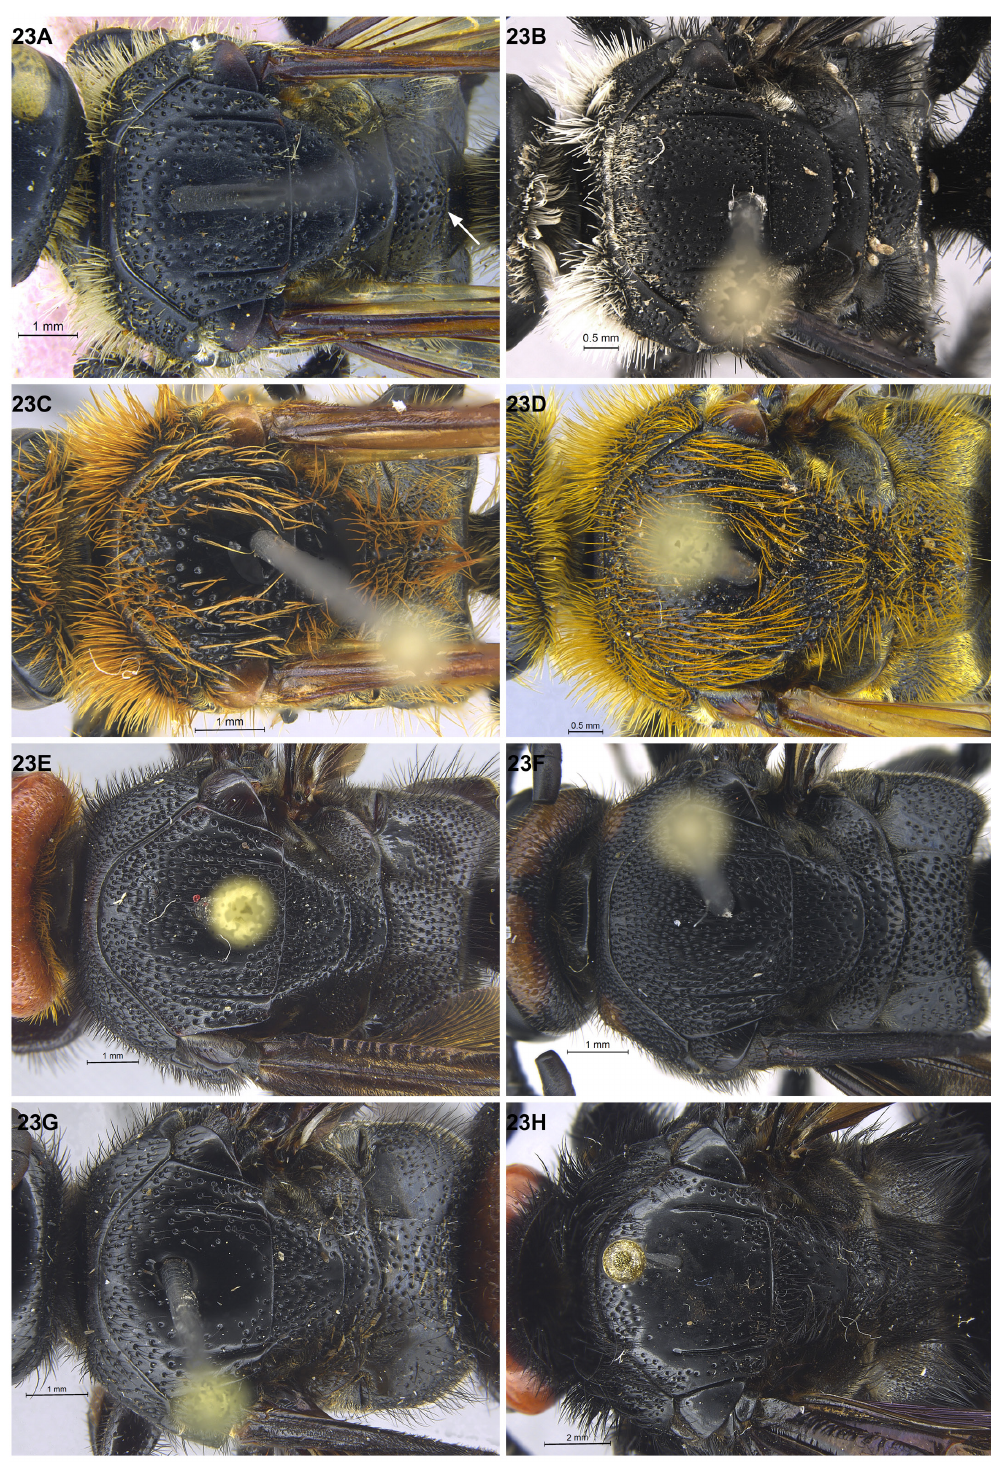
Fig. 23. Females, mesoscutum. A . Campsomeriella annulata annulata (Fabricius, 1793). B . Camps. collaris (Fabricius, 1775) . C . Megacampsomeris formosensis chinensis Betrem, 1941. D . Phalerimeris phalerata phalerata (de Saussure, 1858). E . Austroscolia ruficeps ruficeps (Smith, 1855). F . Carinoscolia junnanensis (Betrem, 1928). G . Liacos erythrosoma (Burmeister, 1854). H . Megascolia azurea (Christ,